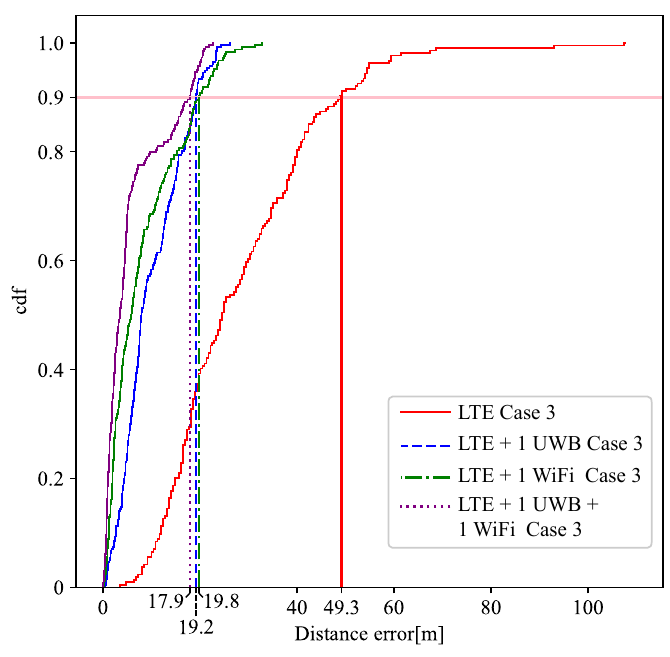
Figure 8. CDF of the horizontal error for Case 3.